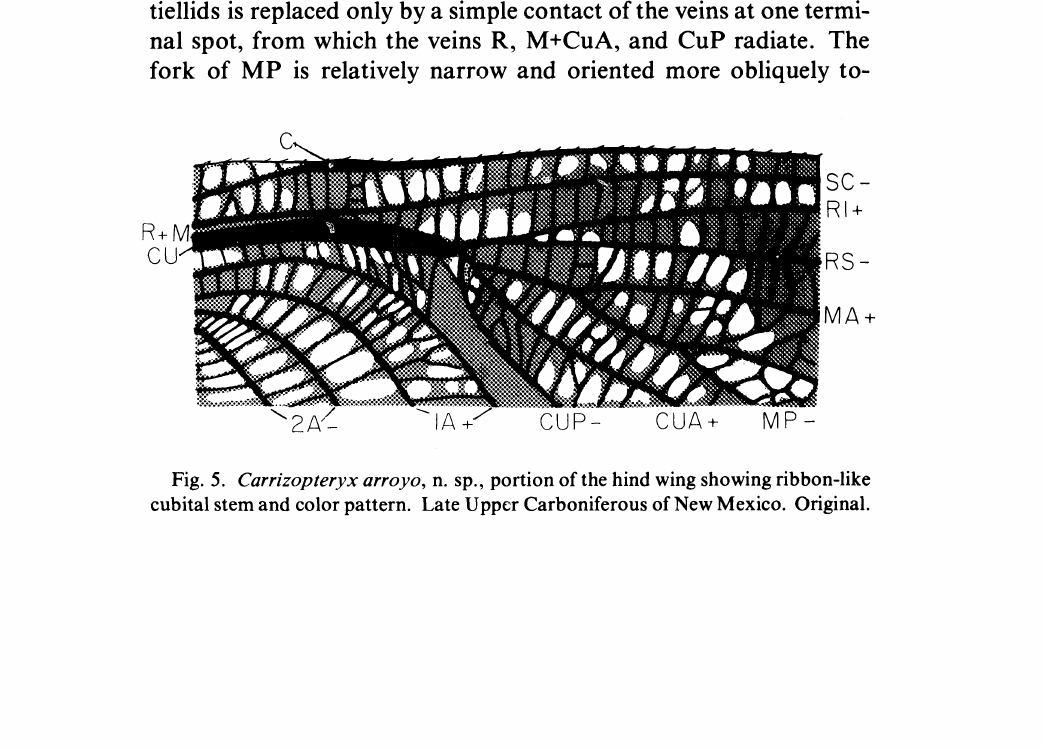
Fig. 5. Carrizopteryx arroyo, n. sp., portion of the hind wing showing ribbon-like cubital stem and color pattern. Late Upper Carboniferous of New Mexico.